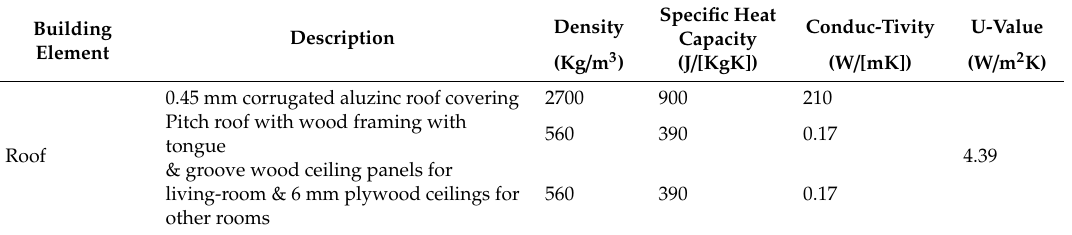
Figure 2. Illustration from northeast direction and layout of the case-study residential building in Ghana. Table 1. Construction and thermal characteristics of the case-study single-family house.